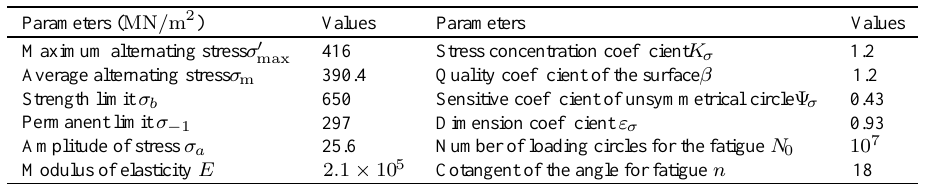
(a) The loads on the tube (b) The loads on the piston rod (c) Bending moments on the piston rod Fig. 10. External and internal forces acting on the absorber in the axle plane. Table 2 Values of strength and material properties for the piston rod